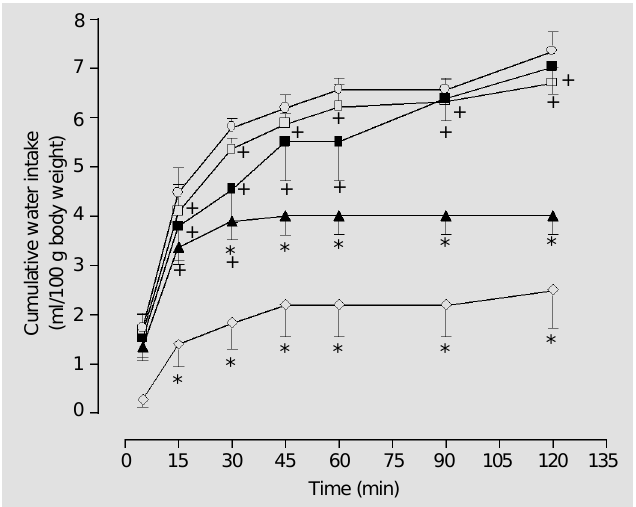
Figure 2 - Effect of naloxone pretreatment on zinc-induced inhibition of water intake in dehydrated rats. Cumulative water intake (ml/100 g body weight) is presented as mean ± SEM in: (open circles) animals pretreated with saline and treated with NaAc (saline + NaAc); (lozenges) animals pretreated with saline and treated with Zn(Ac) 2 at the dose of 3.0 nmol/rat (saline + Zn); (triangles) animals pretreated with naloxone (NAL) (10.3 nmol/ rat) and treated with the same dose of zinc (NAL + Zn); (filled squares) animals pretreated with naloxone (82.5 nmol/rat) and treated with the same dose of zinc (NAL + Zn); (open squares) animals pretreated with naloxone (82.5 nmol/rat) and treated with NaAc (NAL + NaAc). *P<0.05 compared to the saline + NaAc group; + P<0.05 compared to the saline + Zn(Ac) 2 group (ANOVA followed by the Student-Newman-Keuls